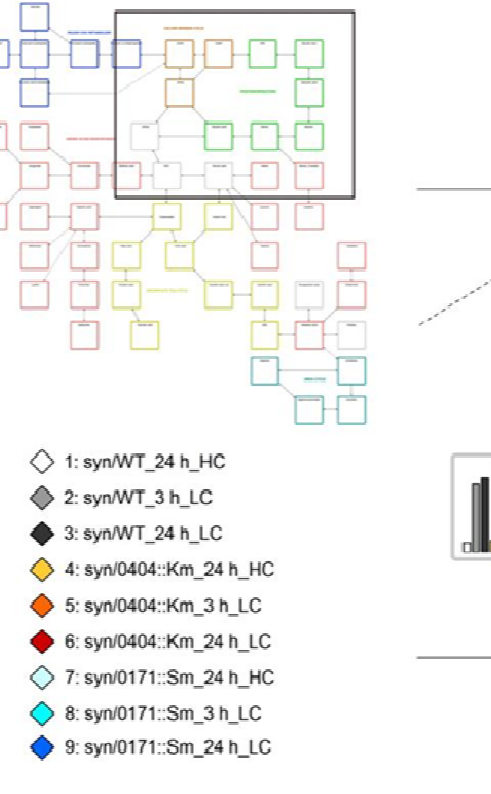
Figure 3. Mapping of metabolite profiles from the glycolate dehydrogenase 1 ( Δ glcD1 ) ( sll0404 ) and the glycine decarboxylase ( Δ gcvT ) ( sll0171 ) mutants to primary metabolism of Synechocystis 6803 wild type. The pathway mapping was customized to the current coverage of GC-MS profiles of primary metabolism. The mapping visualizes the specific metabolic precursor accumulation phenotypes of the photorespiratory mutants defective in glycolate dehydrogenase 1 ( Δ glcD1 ) and in the T-protein subunit of glycine decarboxylase availability. Data were taken ( Δ gcvT ), when shifted from high (5%) to low (0.035%) CO 2 from the supplement of Eisenhut et al. [22]; n.d. (not detected). The top left insert shows the pathway overview and position of the zoom-in on photorespiration. The bottom left insert describes the color-coding of the bar diagrams. The display was partially automated using the VANTED software tool